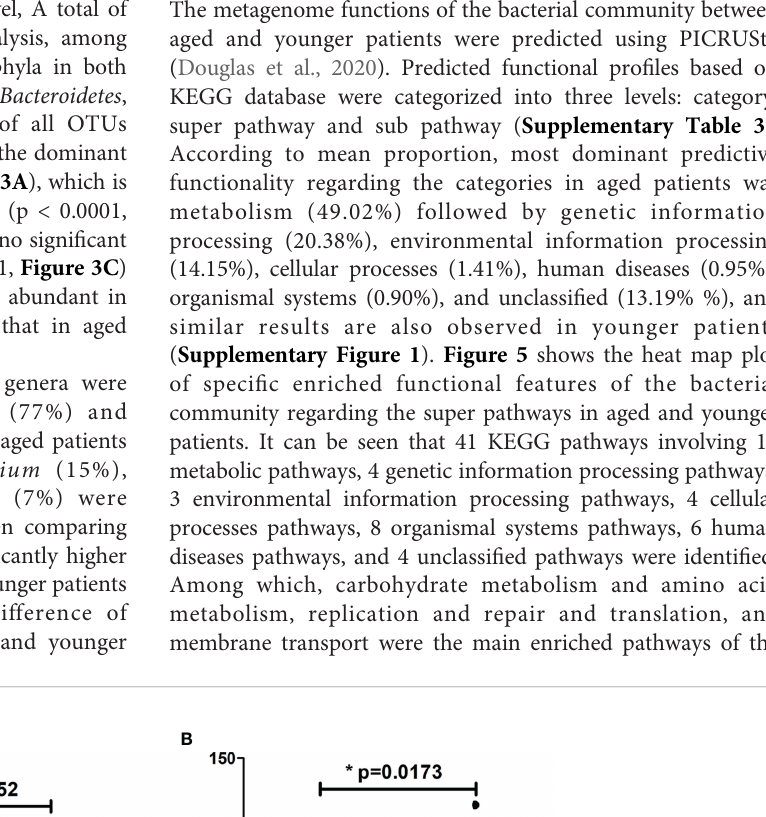
Patients with CRS